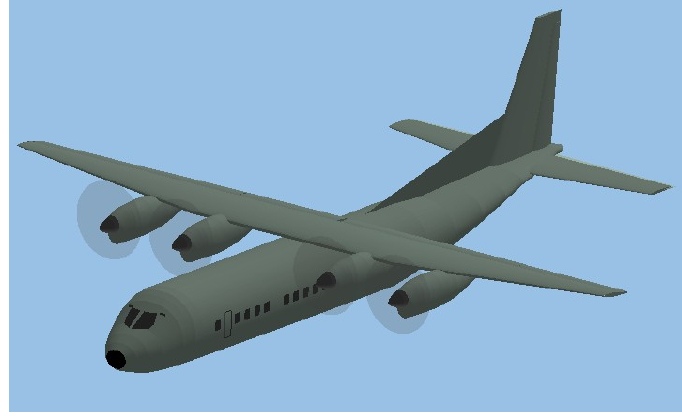
Figure 2. Aircraft model. Table 1. Aircraft